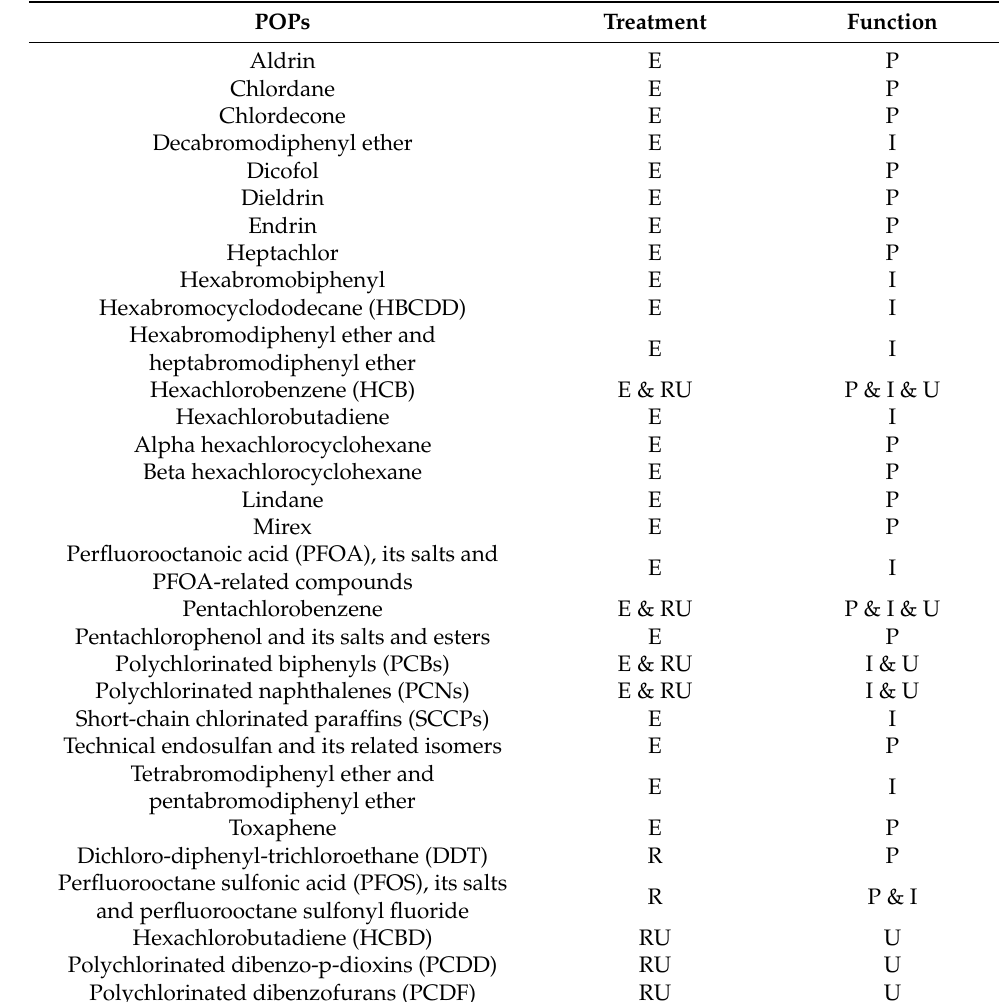
Table 1. All POPs listed in the Stockholm Convention. POPs Treatment